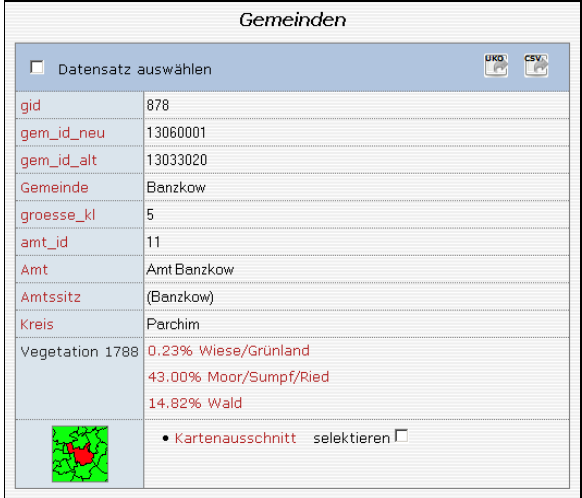
Figure 10. Vegetation area 1788 in the communities